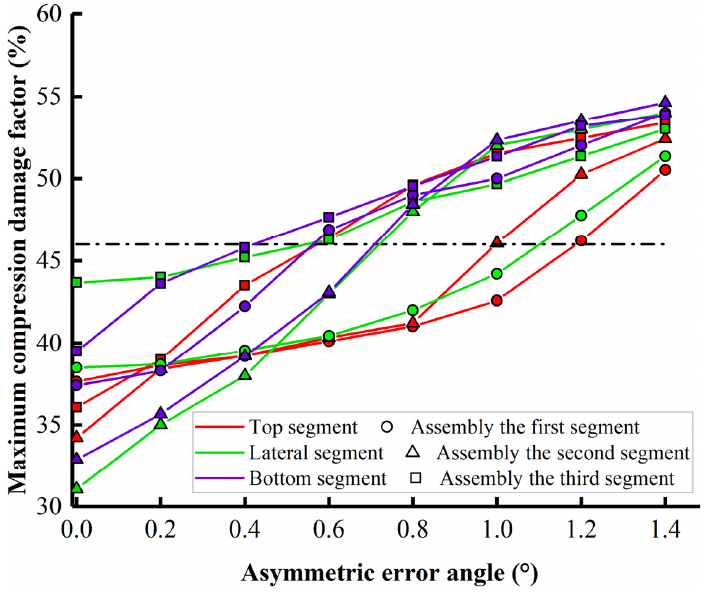
Figure 17. Maximum compression damage factor in the presence of outward deflection.